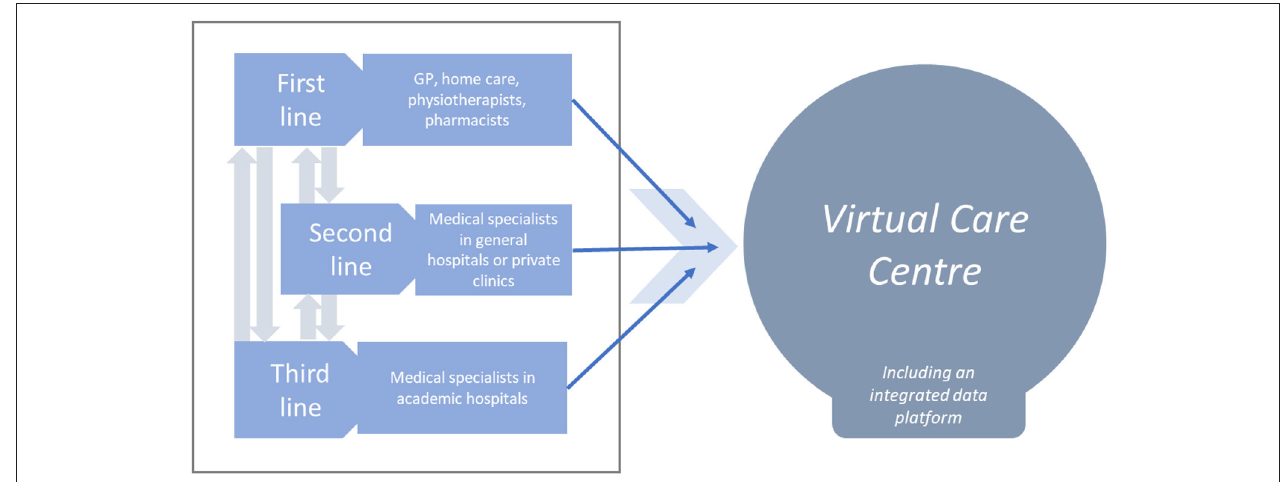
FIGURE 1 | Schematic representation of integrated health care in the virtual care center